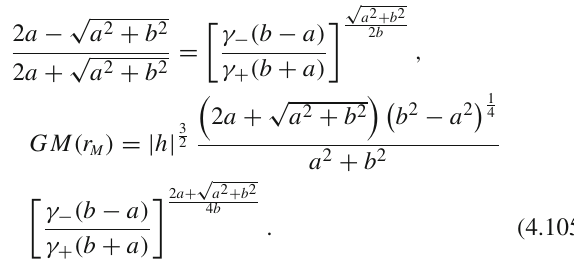
Fig. 1 The parameter space for ( h / | b | , | a | / b ) . In the gray region we have r M > r " , whereas this is not satisfied in the outer white region. The black region corresponds to violation of the weak energy condition and is thus